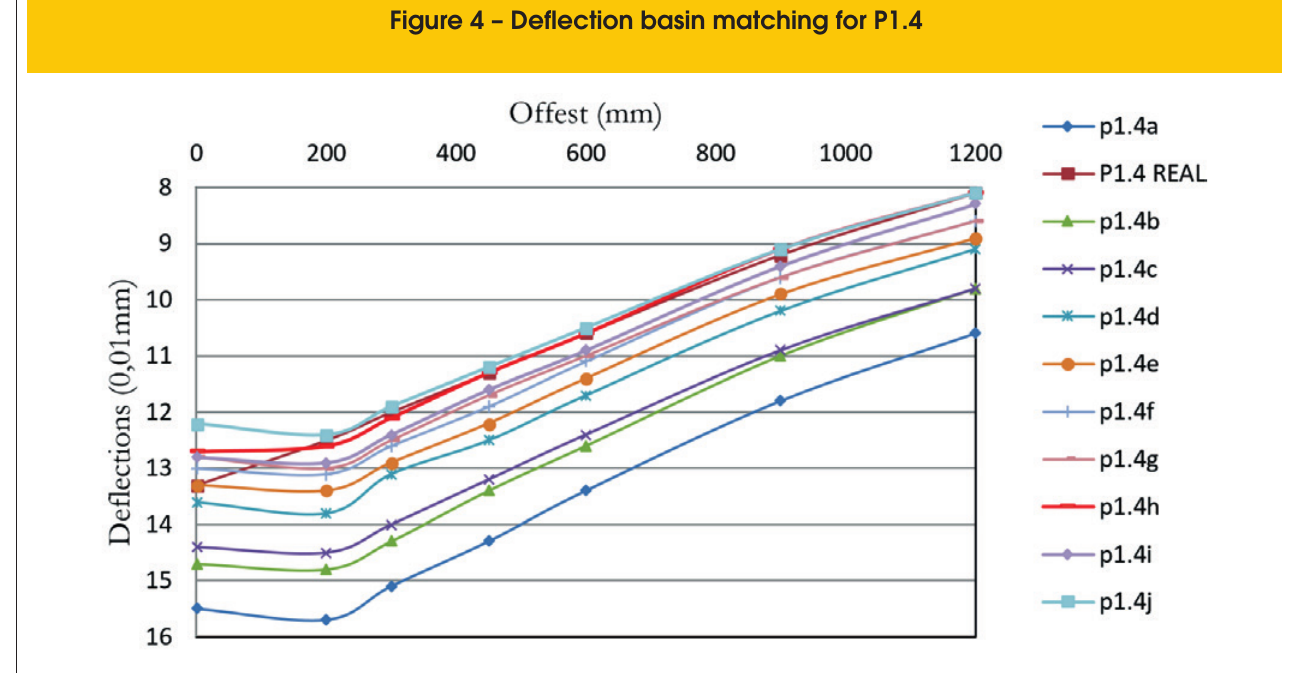
Figure 4 – Deflection basin matching for